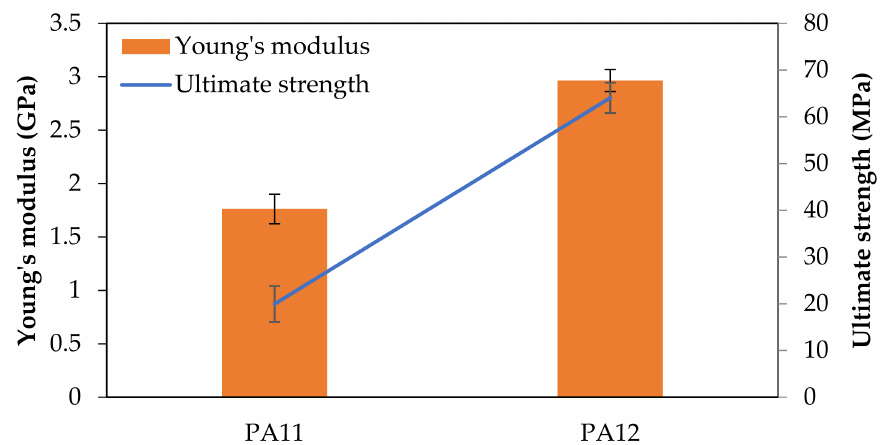
Figure 5. Comparison of tensile properties between PA11 and PA12.